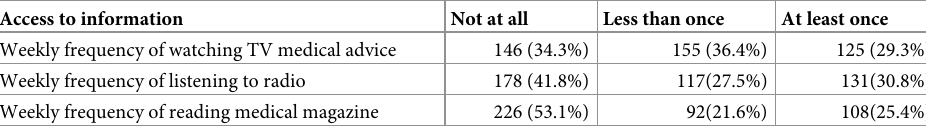
The overall incidence of non-adherence was 10 per 1,000 maternal-days of IFAS use (95% CI: 8.8, 16.6). The Kaplan-Meier survival curve estimate shows the survival probabilities of the maternal IFAS use and the median time to non-adherence was 74 days (95% CI: 65.33–82.67). The log-rank test results showed that the survival curve of IFAS time to non-adherence had statistically significantly difference by women’s educational status ( χ 2 for log-rank test = 65.63, P < 0.001) (Fig 2). Based on Kaplan’s Meier survival estimate, the lower the households’ wealth index, the higher the risk of non -adherence of women to IFAS service and the difference was statistically significant between the groups ( χ 2 for log-rank test = 19.14, P < 0.001). Meanwhile, time to non-adherence of IFAS had statistically significantly difference by counseling status of health institutions ( χ 2 for log-rank test = 58.83, P < 0.001). Table 2. Pregnant women’s access to information in Hosanna town, 2021 (n = 426). Access to information